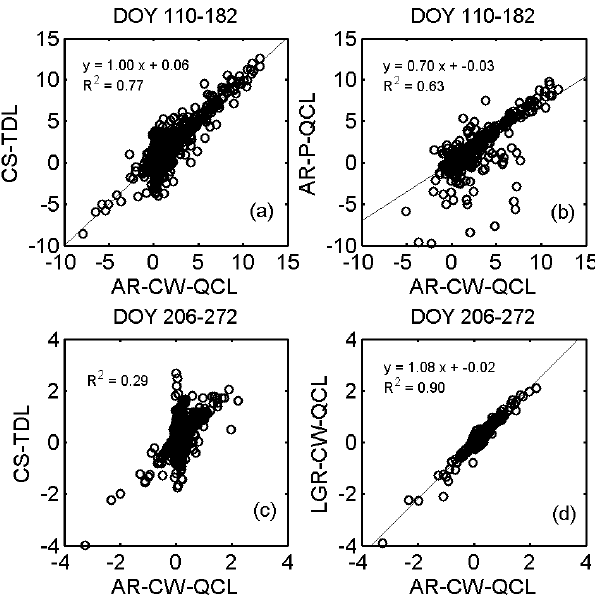
Figure 7. Correlation scatter plots of 30min average N 2 O fluxes (in nmolm − 2 s − 1 ), as measured by CS-TDL and AR-P-QCL vs. AR- CW-QCL during period I DOY 110–181 (a, b) , and CS-TDL and LGR-CW-QCL vs. AR-CW-QCL during period II DOY 206–271 (c, d) . The lines present the linear fit with coefficients presented on the